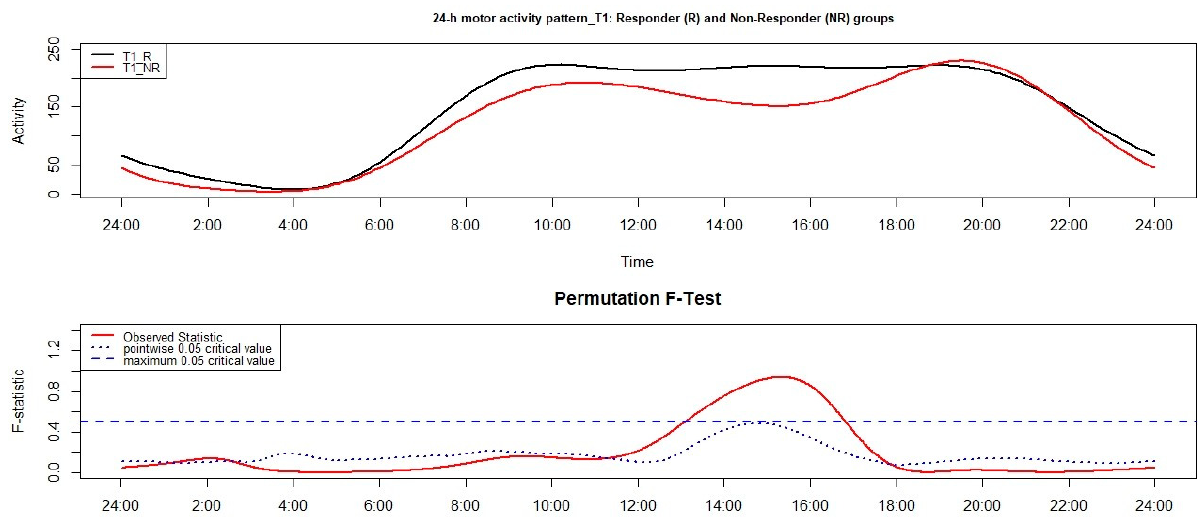
Figure 2. Results of the functional linear modeling applied to the group comparison between responder (R) and non- responder (NR) groups, monitored at T1. The functional forms of the 24-h motor activity patterns of groups are reported in the upper panel while the results of the non-parametric permutation F-test in the lower panel. Significant results are observed when the solid red line is above the blue dashed line.